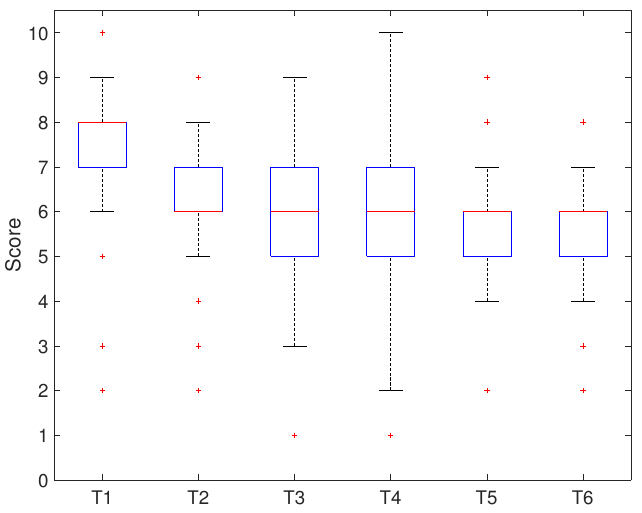
Figure 12. Scores of each assignment